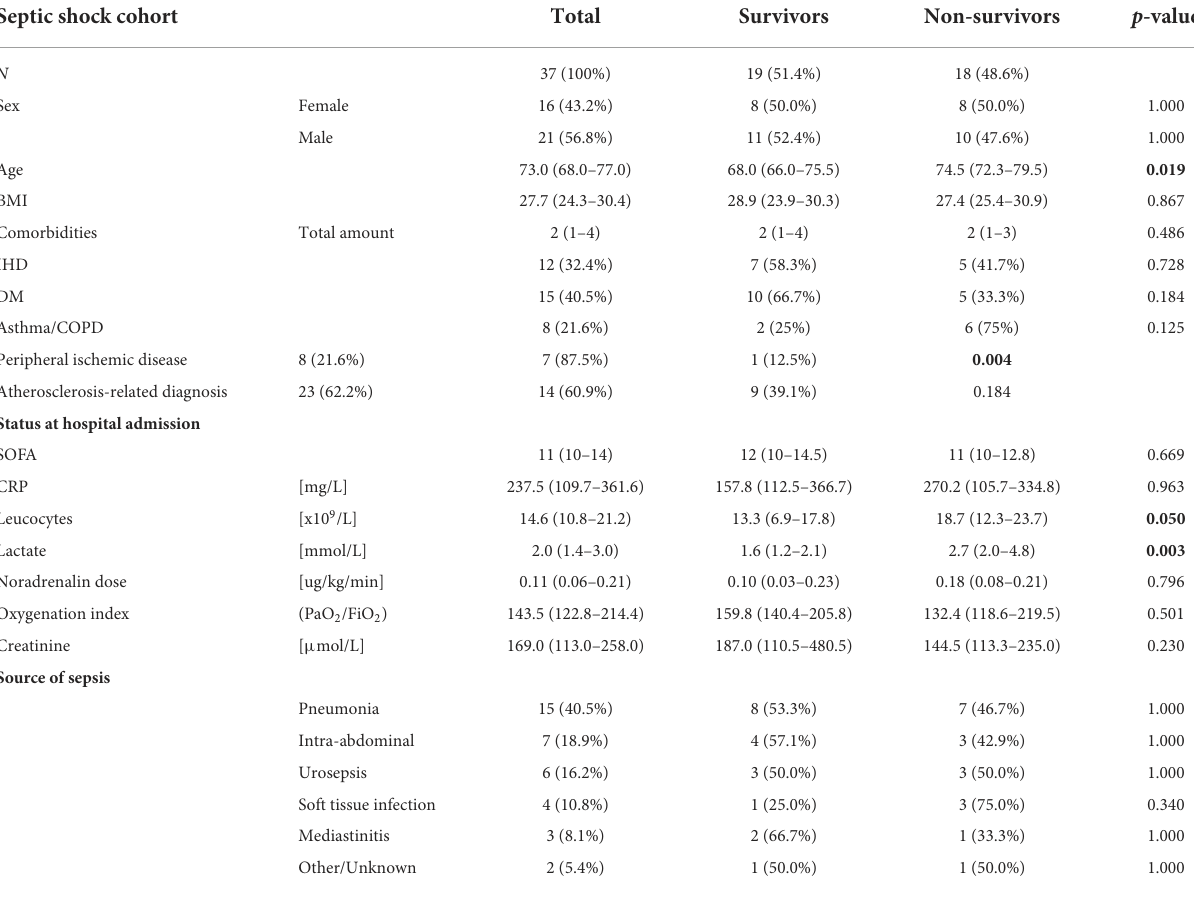
TABLE 1 Demographic and clinical characteristics of patients in septic shock